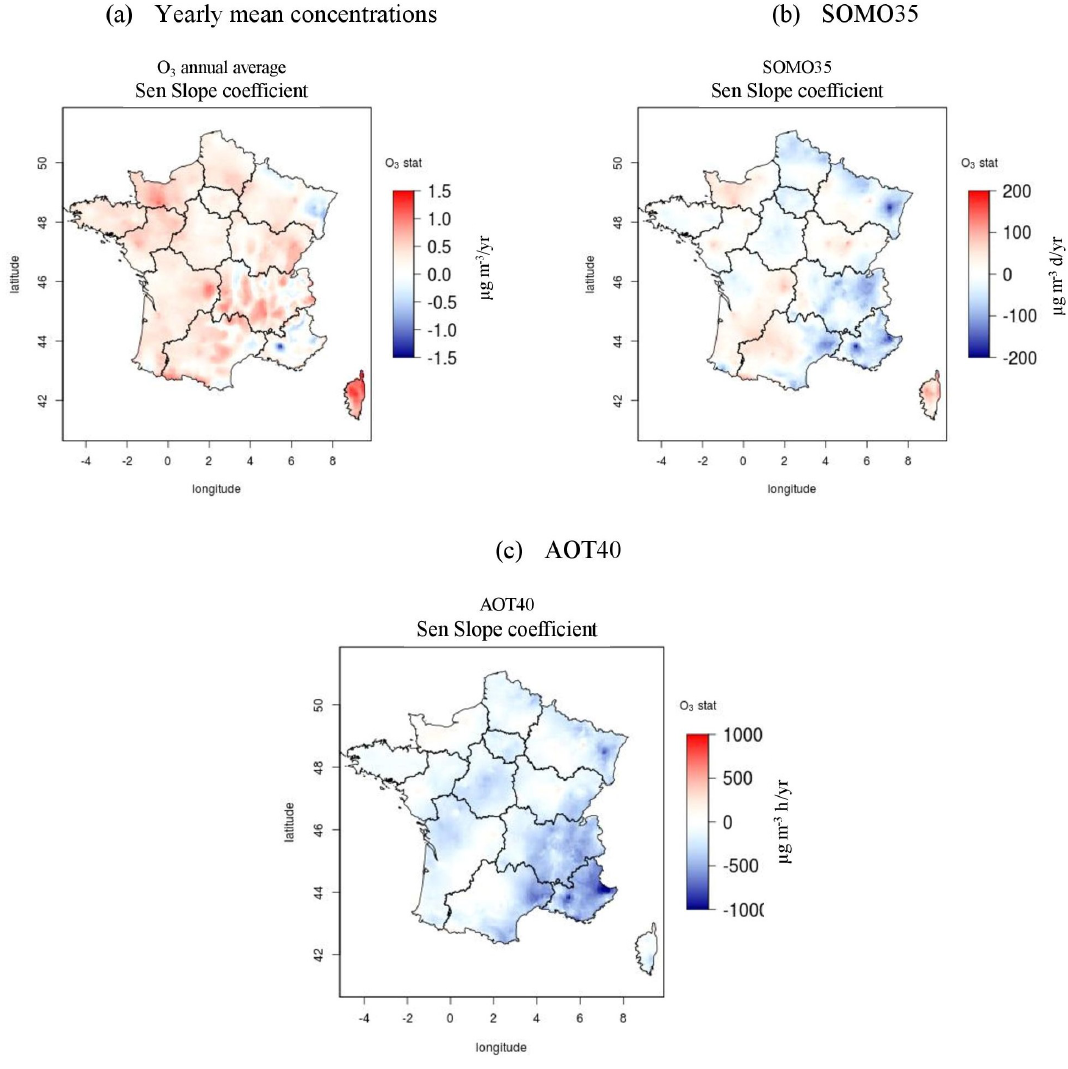
Figure 14. Trends in annual mean O 3 concentrations (in µgm − 3 yr − 1 ) (a) , as well as SOMO35 (in µgm − 3 d − 1 yr − 1 ) (b) and AOT40 (in µgm − 3 h − 1 yr − 1 ) (c) indicators. Sen slope are calculated over the period